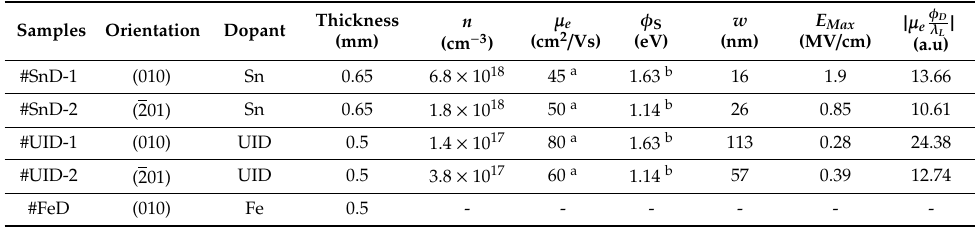
Figure 1. Typical energy band structures for ( a ) an n-type and ( b ) an Fe-doped sample. Table 1. Sample